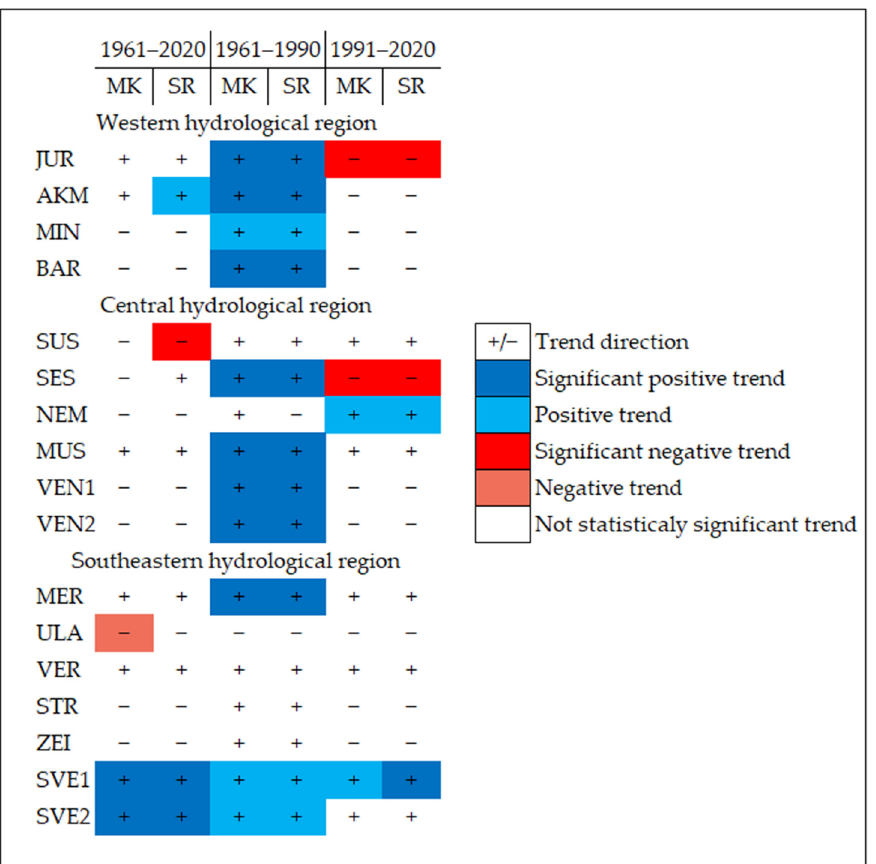
Figure 7. The significance of trends (30Q) by the three periods applying MK and SR tests (red/blue color means that the trend is very significant ( α ≤ 0.05), light red/light blue color means that the trend is significant ( α ≤ 0.1), no color means that there is no significant trend ( α > 0.1)).